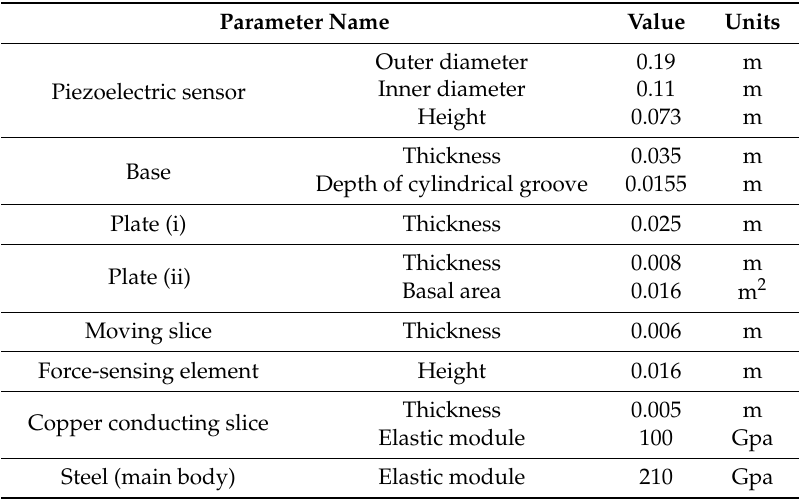
Table 3. Parameters of the piezoelectric sensor and its main Table3. Parameters of the piezoelectric sensor and its main components.